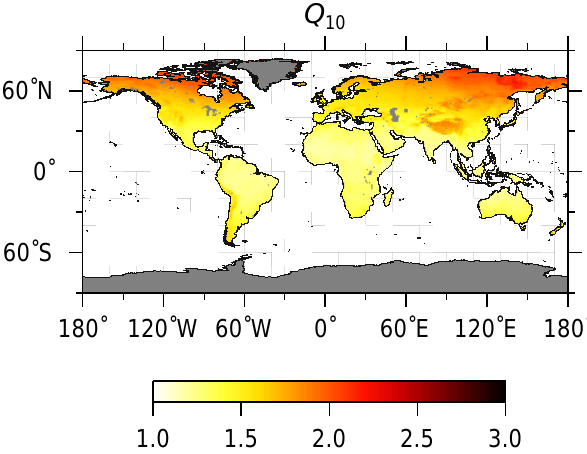
10 values was estimated using the temperature function of Eq. (2) ( f T = exp( aT − bT 2 ) ) and the mean temperature of each grid ( T M ). The Q 10 value was calculated by f T (T M + 5 )/f T (T M −